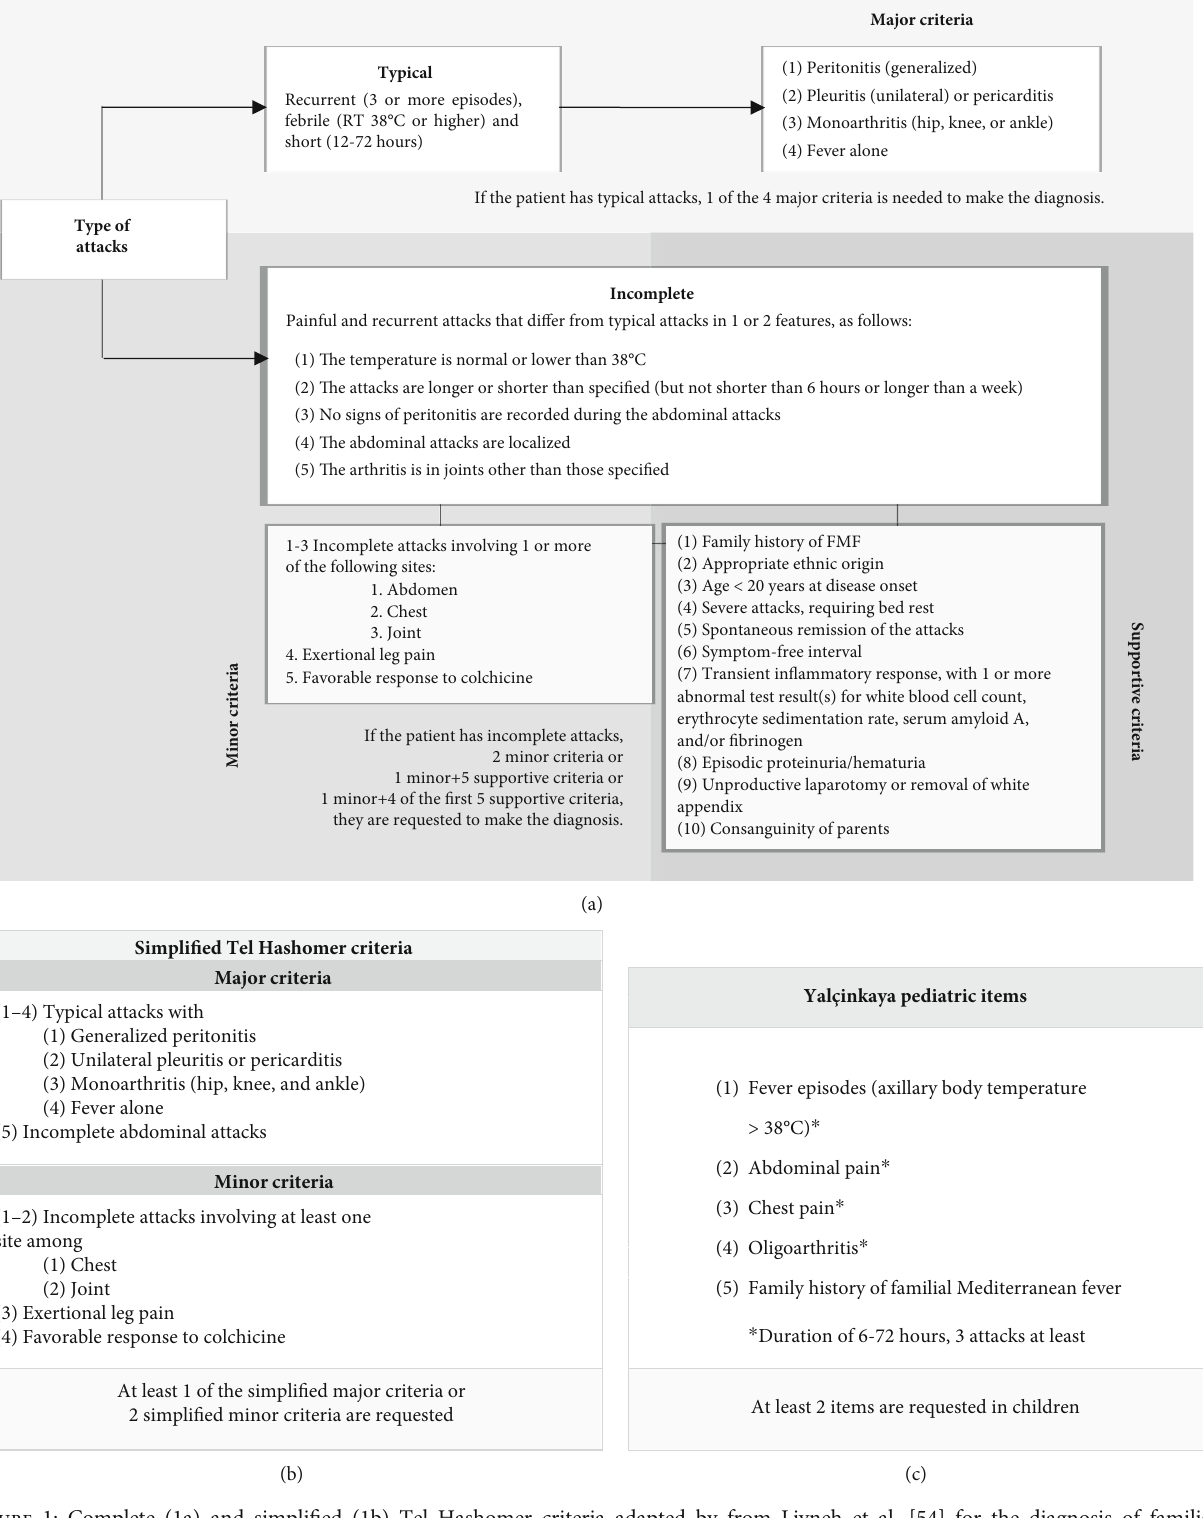
Figure 1: Complete (1a) and simpli fi ed (1b) Tel Hashomer criteria adapted by from Livneh et al. [54] for the diagnosis of familial Mediterranean fever (FMF); Yalçinkaya items (1c) for the diagnosis of FMF in childhood, adapted from Yalçinkaya et al.